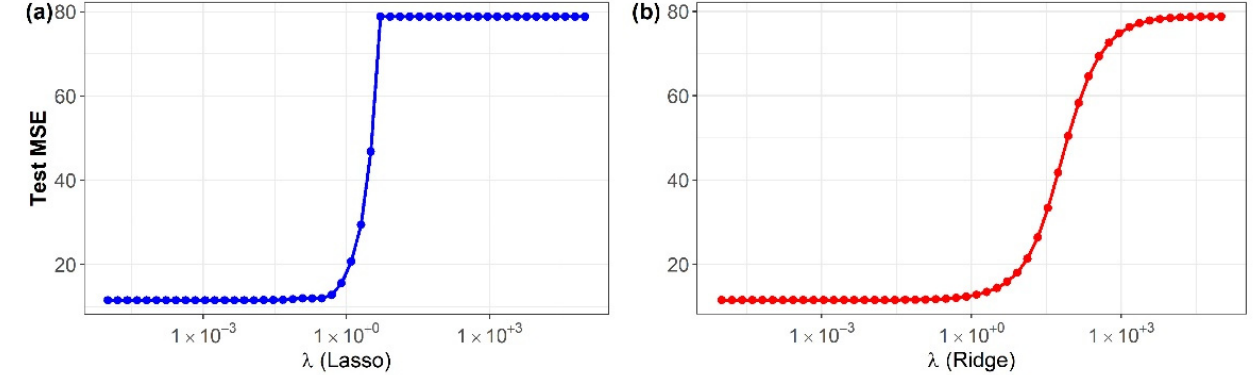
Figure 9. Behavior of the test MSE for the ( a ) Lasso and ( b ) Ridge regressions.